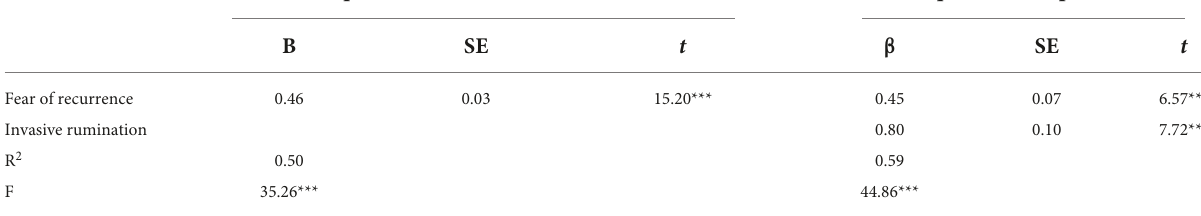
TABLE 5 Analysis of mediating role of invasive rumination in fear of recurrence and